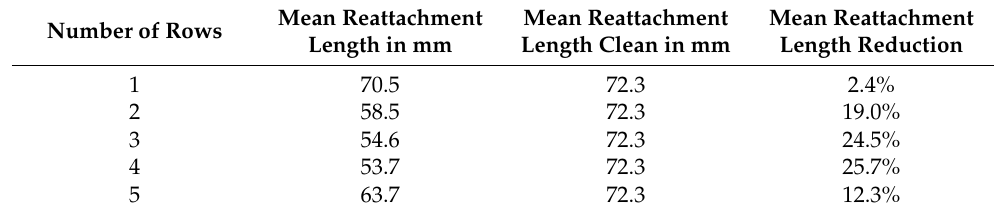
Table 7. Calculated reattachment lengths for different numbers of rows of the type A wire